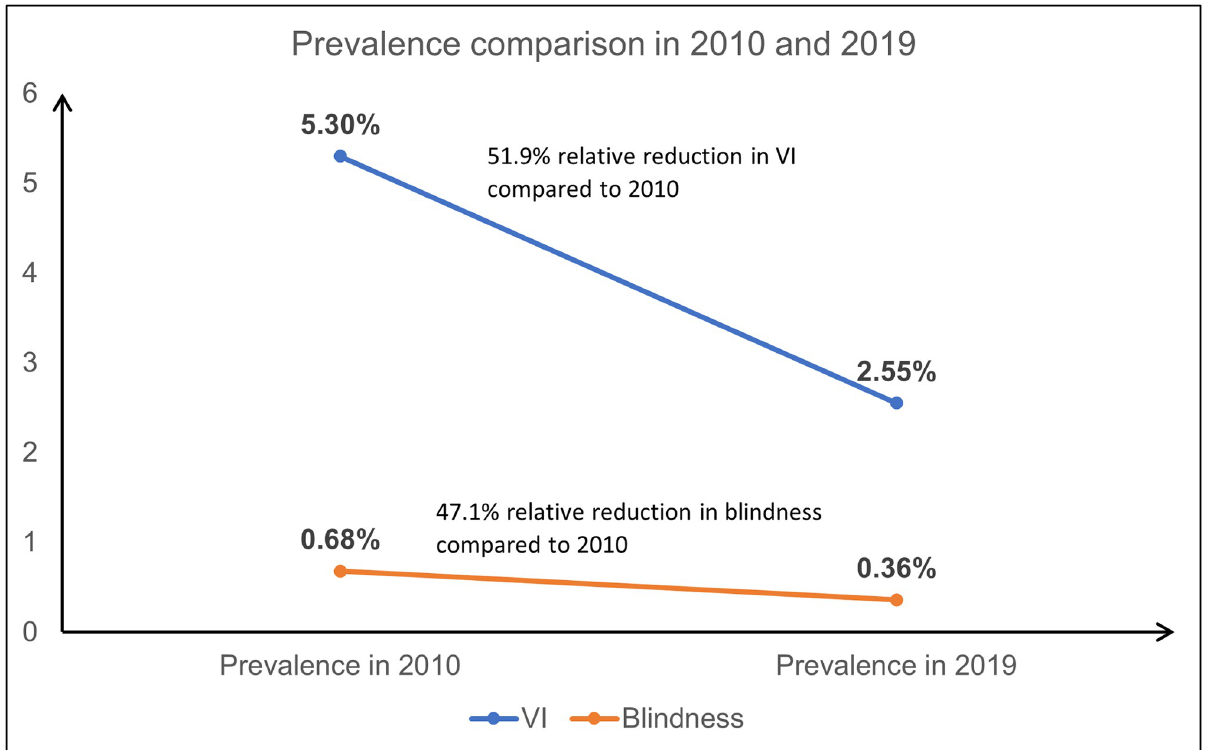
Fig 4. Reduction in blindness and visual impairment from 2010 estimates in overall